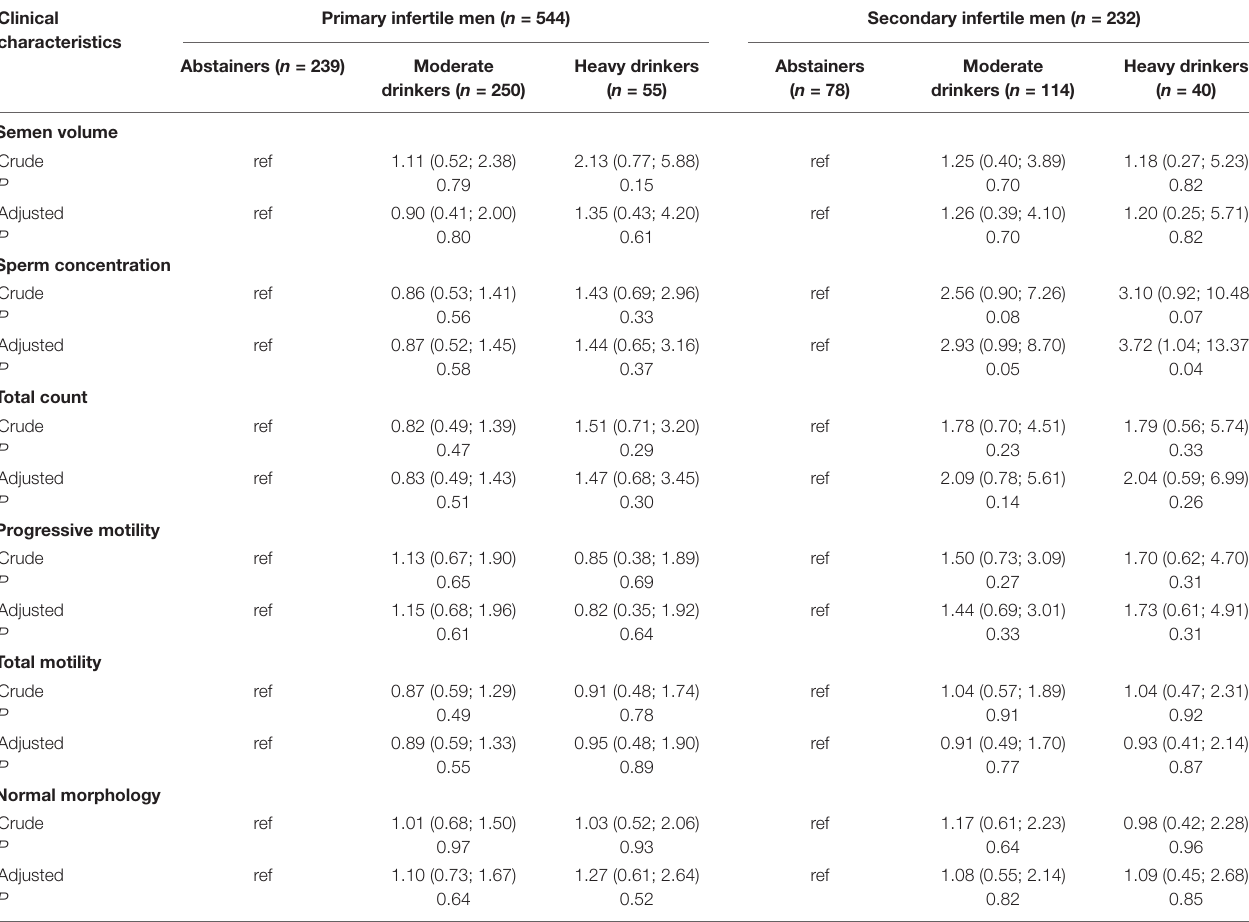
TABLE 3 | Odds ratios (95% confidence intervals) for abnormal semen parameters across different levels of alcohol